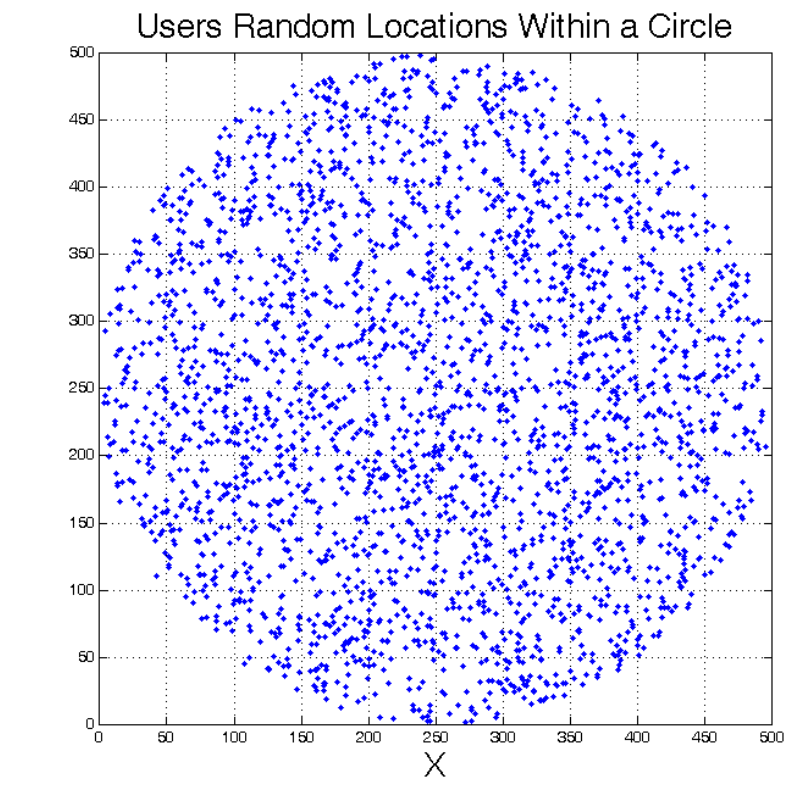
Figure 5. Top view of uniformly distributed active users inside the circle subarea with a radius of 250 m, when n = 16.